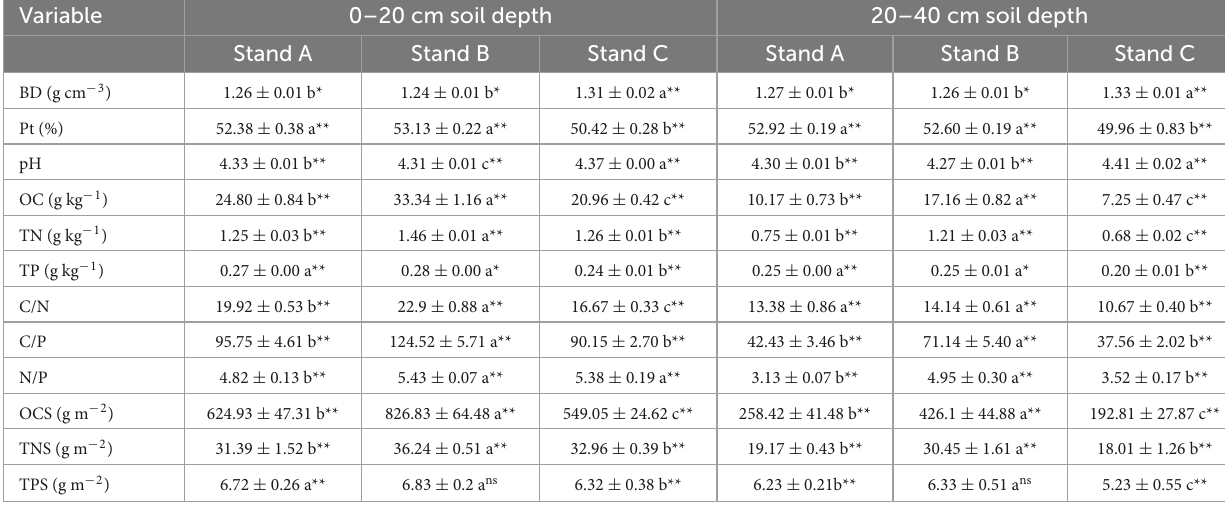
TABLE 2 Bulk soil properties in Chinese fir plantations with different stand types. Variable